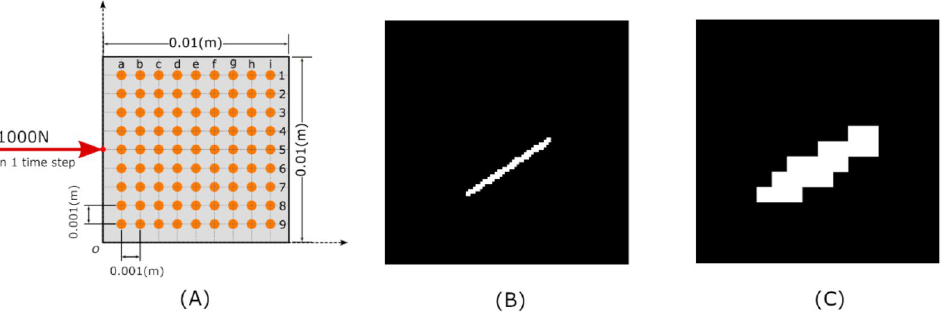
Figure 1. Configurations for the dataset: ( A ) The receiver arrangement on the surface of a plate; ( B ) a 100 × 100 binary labelling image; ( C ) the corresponding 16 × 16 binary labeling image.